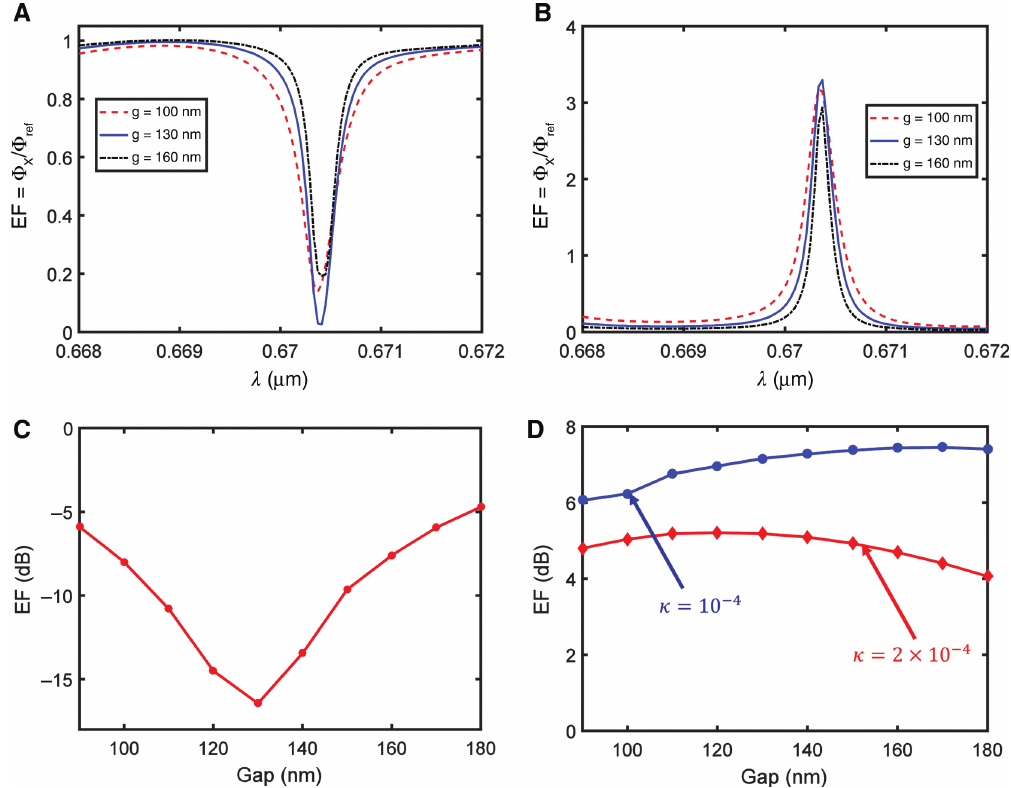
Figure 5: (A) [resp. (B)] Spectra of the power traveling along the output waveguide normalized to the power of a reference waveguide (with no resonator) in the case of bus-waveguide (resp. TWR) excitation for separation gaps of 100 nm, 130 nm, and 160 nm. The computations are conducted by imposing an extinction coefficient of κ = 2 × 10 −4 to the refractive index of the 8 μ m radius resonator.(C) Extinction factor ( EF ) (output waveguide power normalized to reference waveguide power) for bus-waveguide excitation of the resonator. The critical coupling condition is achieved for a separation gap of g = 130 nm ( κ = 2 × 10 −4 , Q = 2500). (D) Enhancement factor ( EF ) (output waveguide power normalized to reference waveguide power) in the case of local TWR excitation. For an extinction coefficient of κ = 2 × 10 −4 , the enhancement factor is maximum at g = 130 nm corresponding to the critical coupling condition [see (C)]. By reducing resonator intrinsic losses ( κ = 1 × 10 −4 , Q around 5500) the enhancement factor rises above the optimum value obtained for κ = 2 × 10 −4 whatever the separation